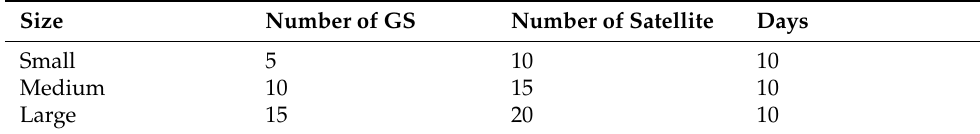
Table 3. Original